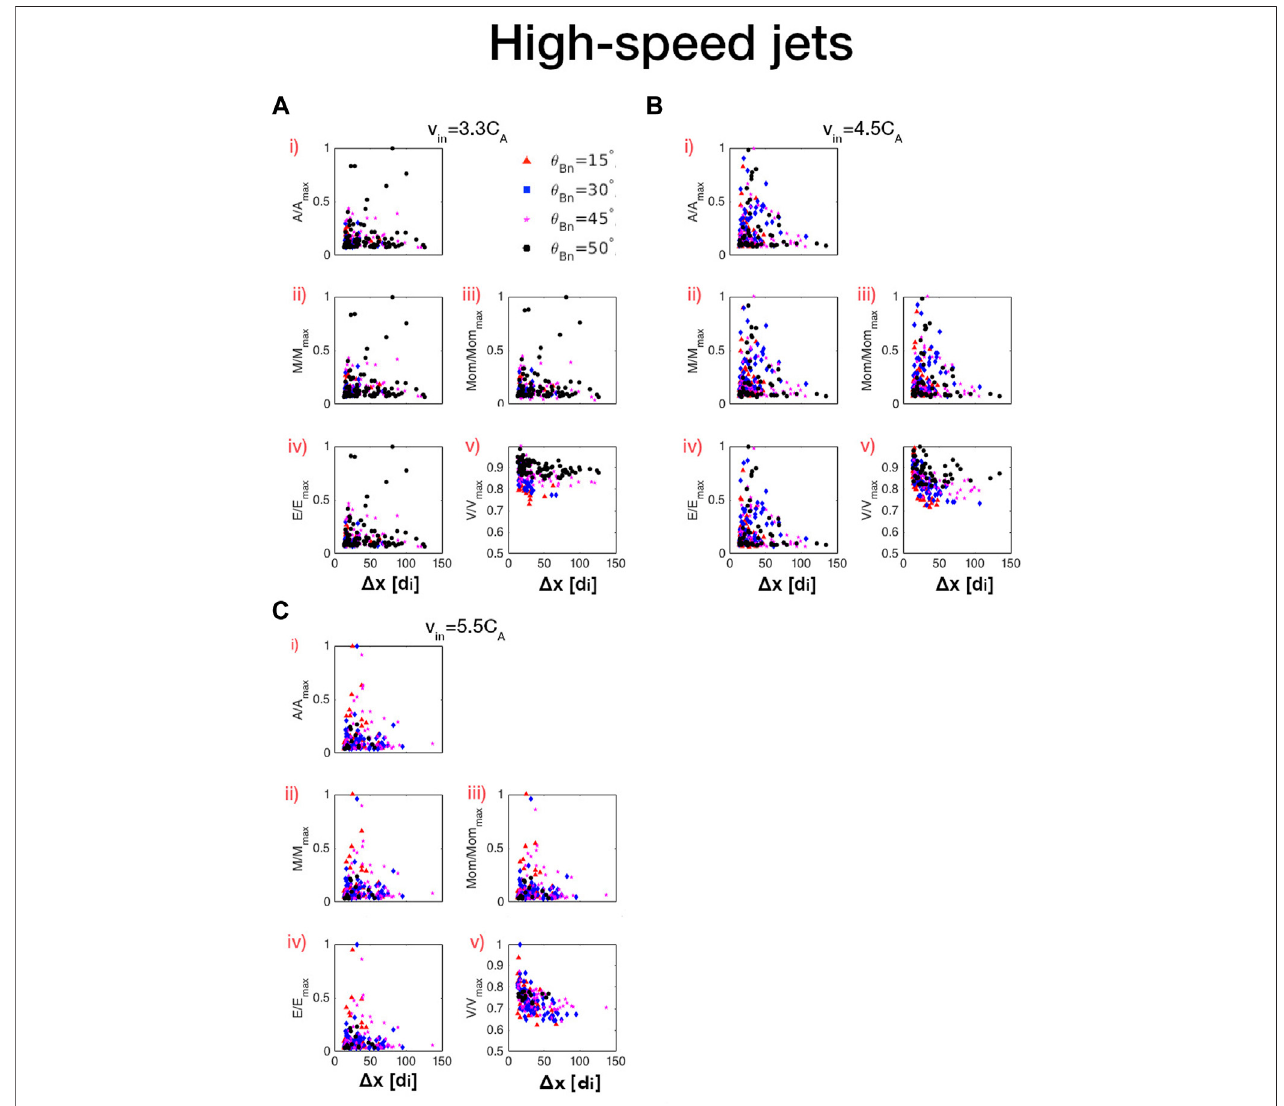
FIGURE7| Scatterplotsofpropertiesofhigh-speedjetsasafunctionoftheirdistancefromtheshock.Panels (A – C) showresultsforrunswithV in =3.3C A ,4.5C A and 5.5 C A . Panels (i – v) show normalized area, mass, linear momentum, kinetic energy and velocity. All the quantities are normalized to the highest value on each panel. Red triangles, blue squares, purple asterisks and black dots represent jets from runs with θ BN = 15 ° , 30 ° , 45 ° , and 50 ° , respectively.